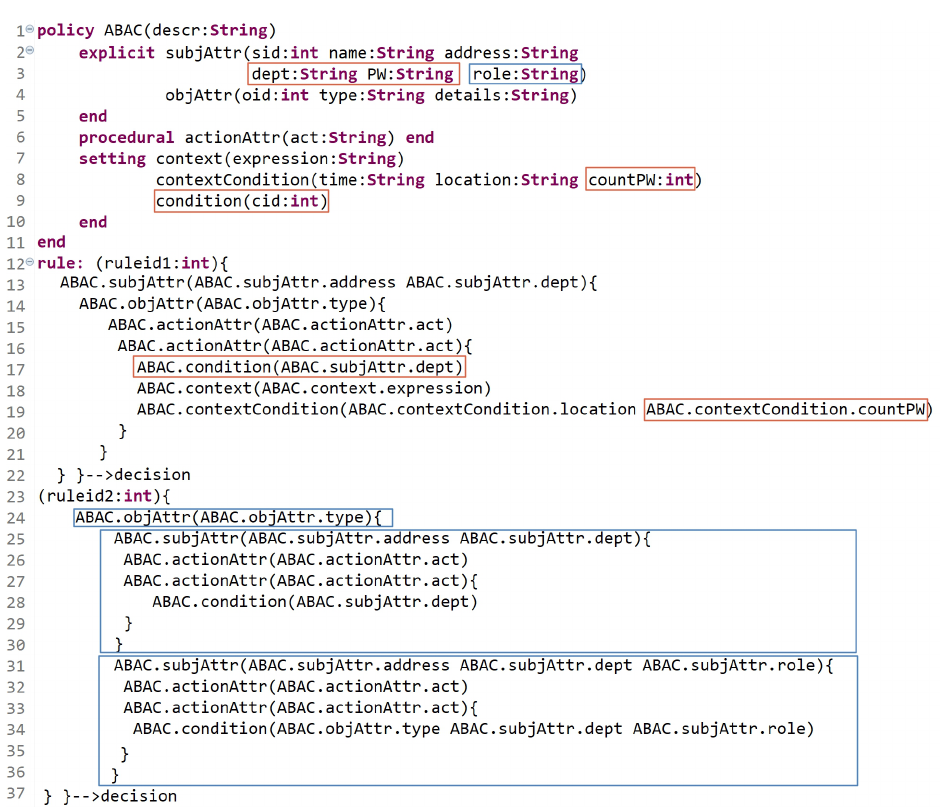
Figure 19. Dynamic AC metamodel: Scenario